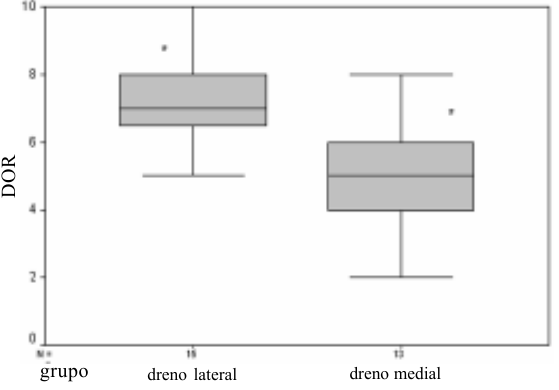
em 1 Fig. 5 - Distribuição representativa da média do escore de dor no primeiro dia de PO, comparação entre os grupos com inserção do dreno pleural nas regiões lateral e medial.